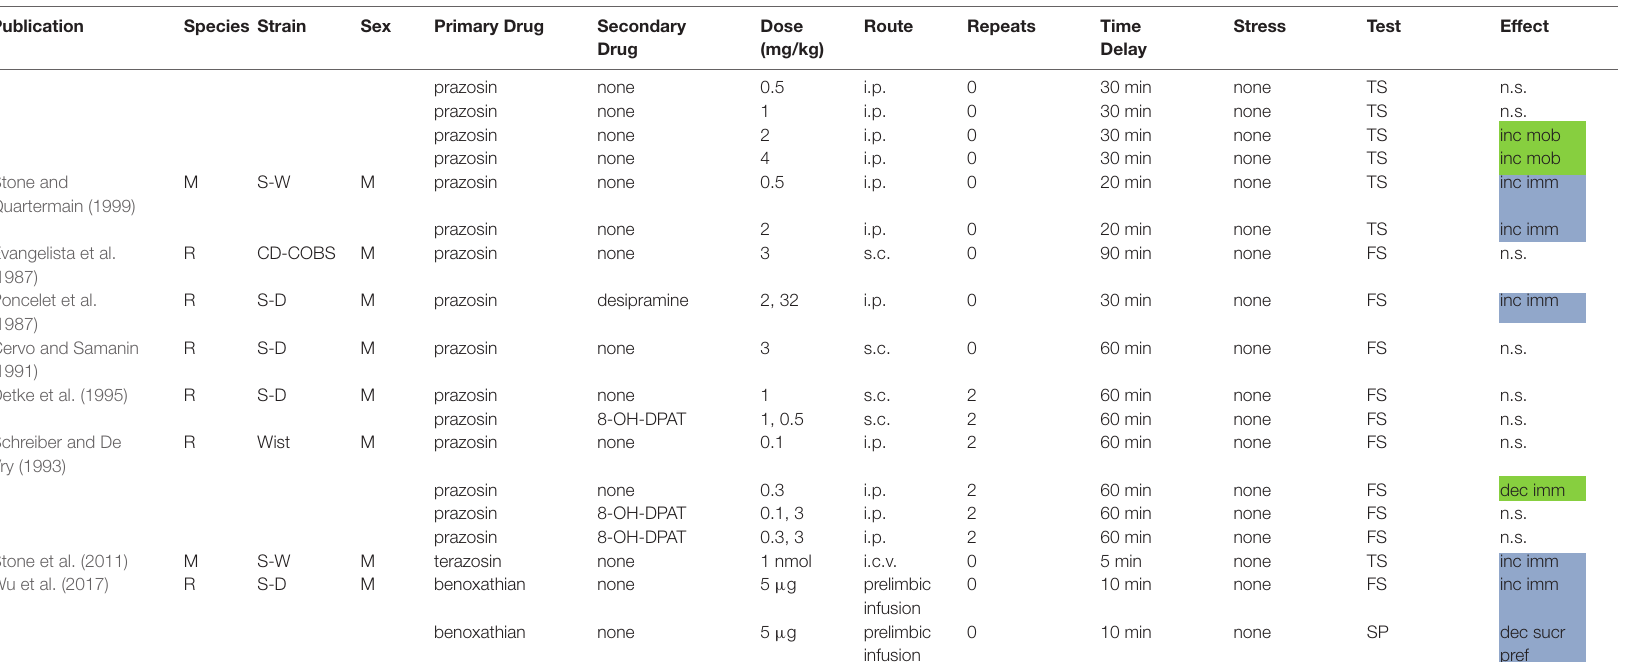
column compares the behavioral effect of the pair with when one drug alone was given in that experiment. All experiments that used a prior stressor are marked in red. Experiments that showed a statistically significant antidepressant-like effect are marked in green, whereas those with a depression-like effect are marked in blue. Other abbreviations: [Species: mouse (M), rat (R)], C57BL/6J (C57), Sprague-Dawley (S-D), Swiss Webster (S-W), Wistar (Wist), [Sex: male (M), female (F)], lipopolysaccharide (LPS), intraperitoneal (i.p.), subcutaneous (s.c.), intracerebroventricular (i.c.v.), once a day (q.d.), twice a day (b.i.d.), social defeat (soc defeat), maternal separation (mat sep), social isolation (soc isol), single prolonged stress (SPS), decreased immobility (dec imm), increased immobility (inc imm), increased mobility (inc mob), increased swimming (inc swim), increased climbing (inc clim), decreased sucrose preference (dec sucr